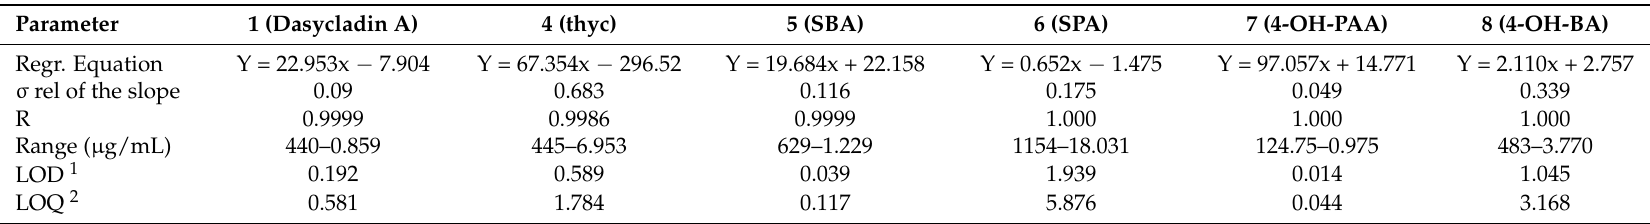
Table 2. Calibration data for the coumarins isolated from the marine green alga Dasycladus vermicularis and the respective phenolic acids. Parameter 1 (Dasycladin A) Regr. Equation Y = 22.953x − 7.904 σ rel of the slope